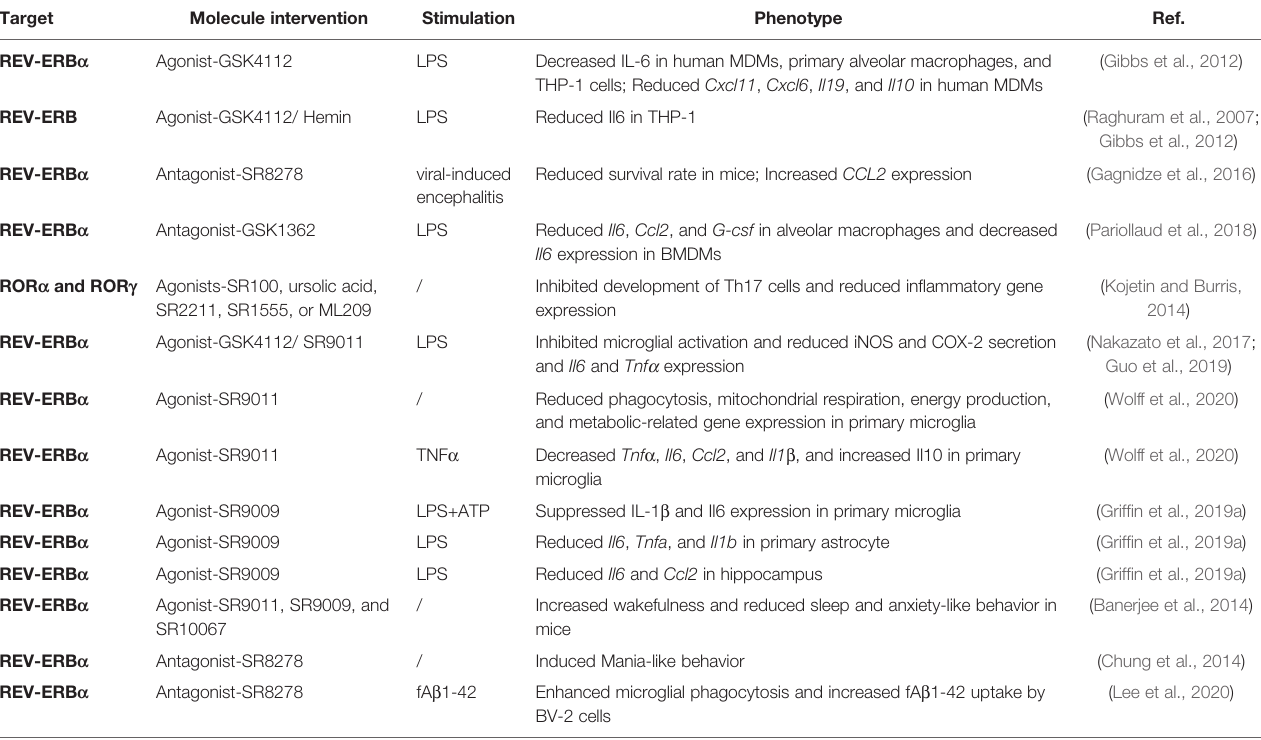
TABLE 2 | Molecule intervention of circadian clock under different